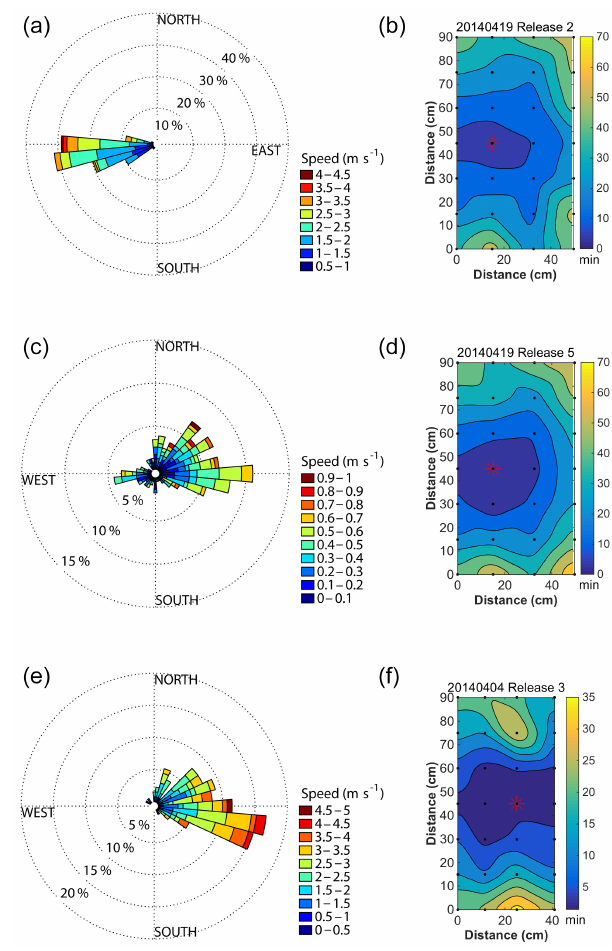
Figure 7. Windrose for persistent wind case 8 in 430kgm − 3 snow (a) ; for light, variable wind case 11 also in 430kgm − 3 den- sity snow (c) ; and for persistent wind with 249kgm − 3 density snow case 4 (e) . Winds are plotted relative to pickets such that the tops of plots (b) , (d) and (f) align with the north direction of the windroses. Wind speed is color coded with speed ranges given in the legend. Time to maximum concentration is color-filled by minutes from re- lease time for case 8 (b) , case 11 (d) and case 4 (f) . Contours are in 10min increments for panels (b) and (d) and 5min increments for panel (f) . CO sensor positions are marked as black dots and the release point with red